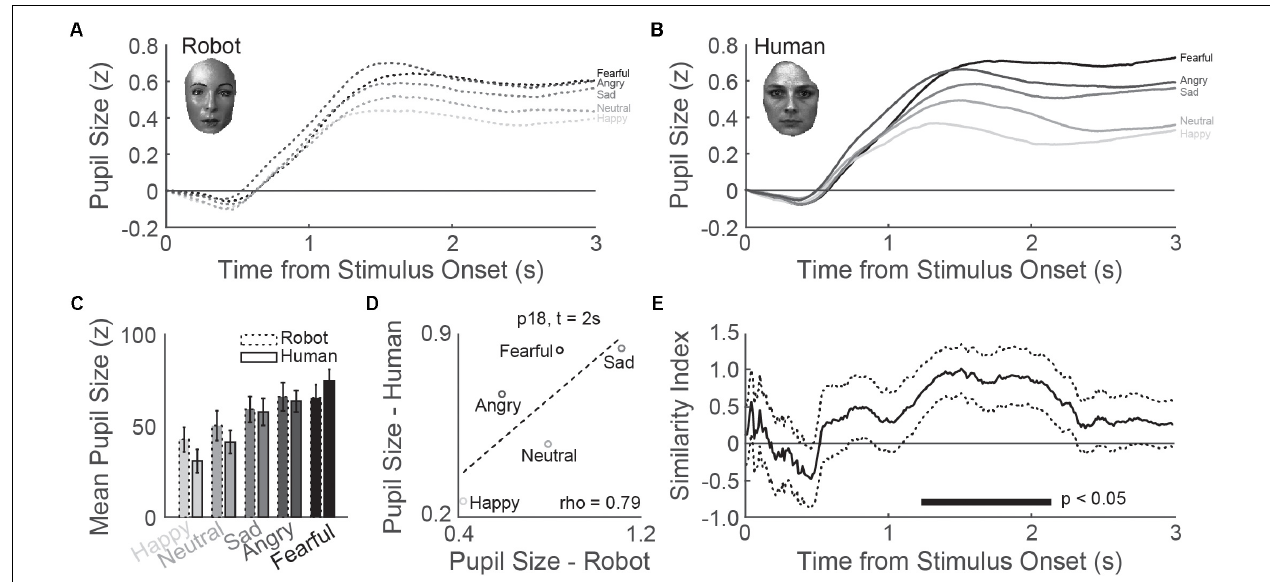
FIGURE 3 | Media equation confirmed: pupil response similarity between robot and human emotions. (A,B) Average pupil responses to robot faces across participants were comparable to human faces. (C) Average pupil dilation between 1 and 3 s was larger for robot and human emotions with a negative valence. (D) Example correlation between average pupil size for human ( y -axis) versus robotic ( x -axis) faces across emotional expressions. (E) Similarity index as a function of time after stimulus onset, based on the correlation between robot and human average pupil size across emotions (see D ), indicated significant overlap in pupil response profiles between ∼ 1 and 3 s after emotion onset. The horizontal bar at the bottom indicates at which time points the similarity index was significantly larger than zero. The dotted lines indicate the standard error of the